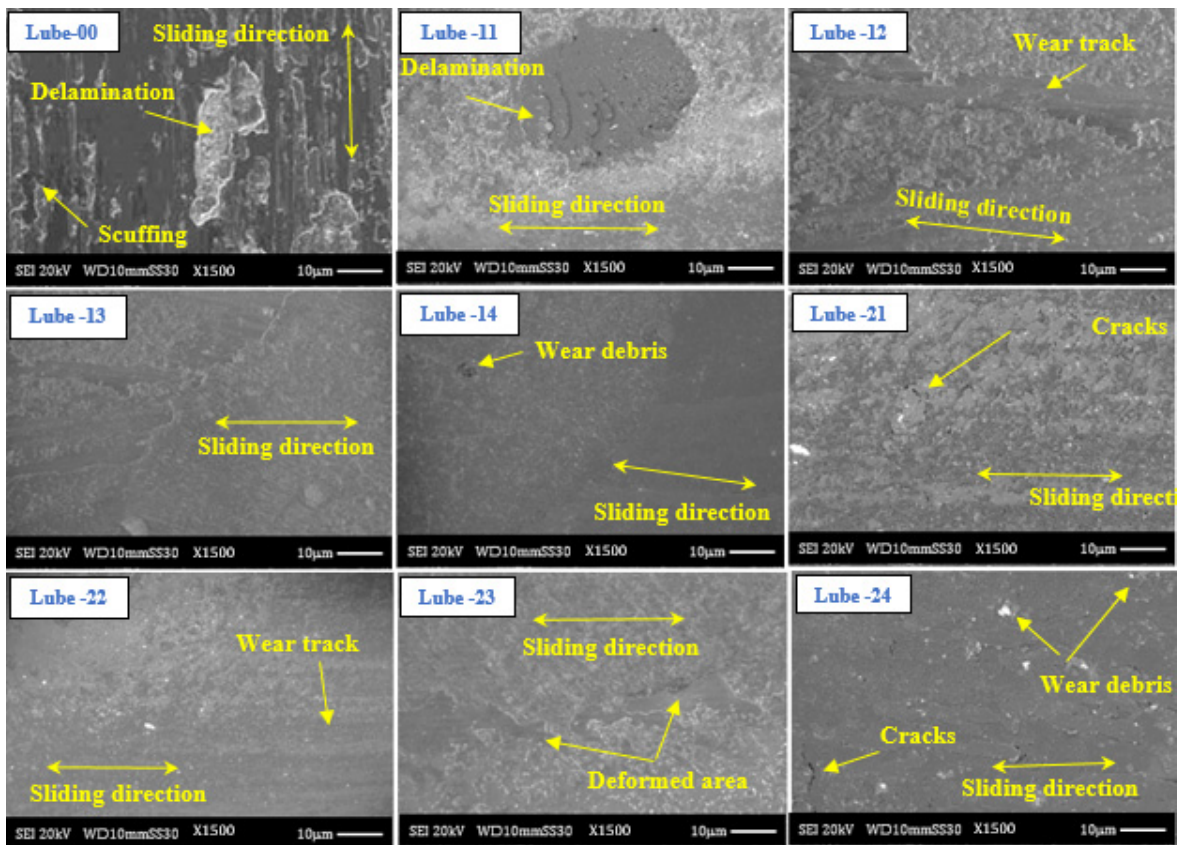
Figure 10. SEM images of hybrid nano lubricant samples, i.e., Lube-00, Lube-11, Lube-12, Lube-13, Lube-14, Lube-21, Lube-22, Lube-23, and Lube-24.